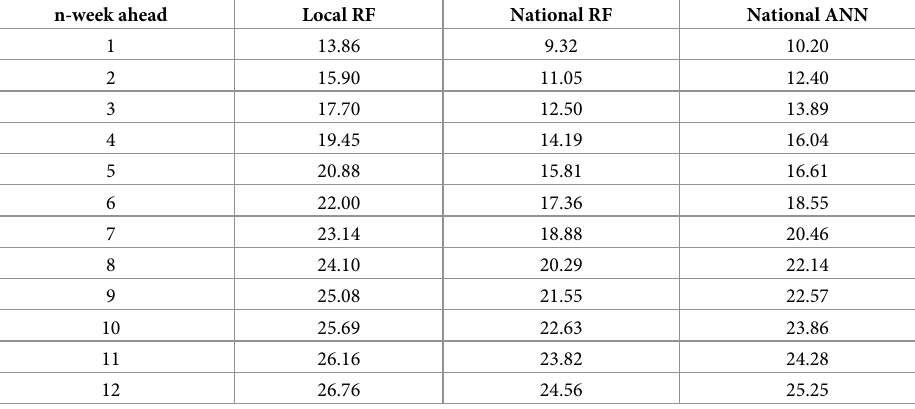
Table 4. Average MAEs of the leave-one-season-out